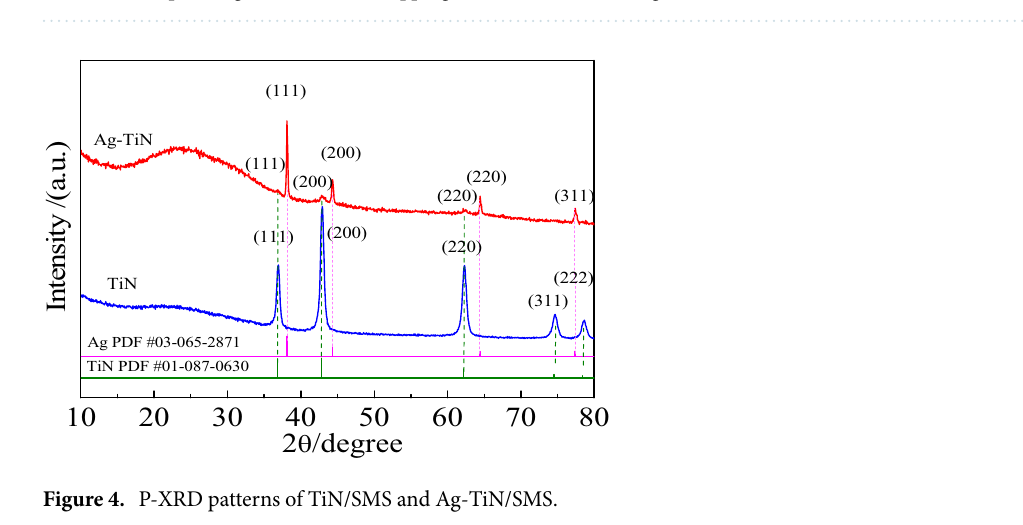
Figure 3. EDX Drift corrected spectrum images of TiN/SMS ( a ) and Ag-TiN/SMS ( b ); HAADF-STEM images and the corresponding EDX element mapping of TiN/SMS ( c ) and Ag-TiN/SMS ( d ).